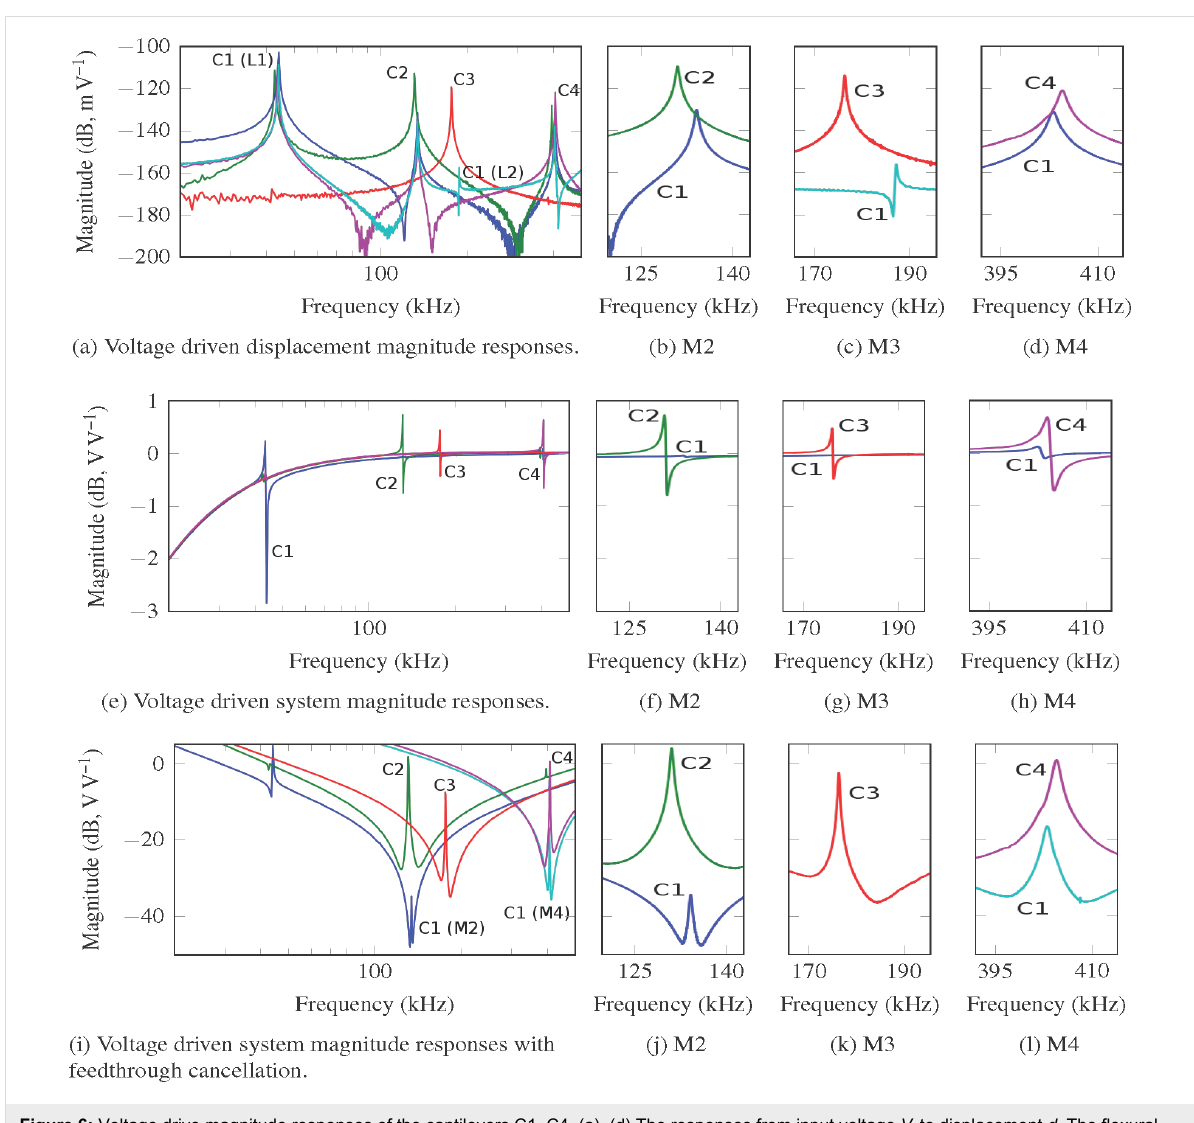
Figure 6: Voltage drive magnitude responses of the cantilevers C1–C4. (a)–(d) The responses from input voltage V i to displacement d . The flexural modes of C1, C2, and C4 are measured at location 1 (L1). The torsional modes of C1 and C3 are measured at location 2 (L2) (see Figure 2m). (e)–(h) The responses from V i to output voltage V o . To show the resonance more clearly, the plots for C1–C4 are moved to 0 dB with a shift of − 15.21 dB, − 18.85 dB, − 16.6 dB and − 16.57 dB respectively to account for the affect of different values of C p in each cantilever. (i)–(l) The responses from V i to sensor output V d . (b)–(d), (f)–(h) and (j)–(l) show higher resolution plots of the